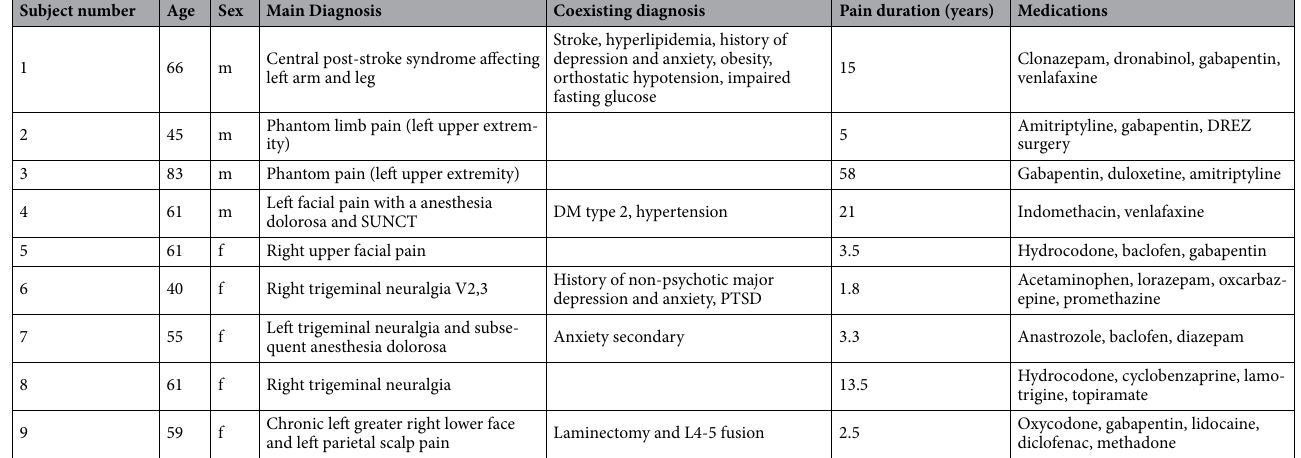
Table 1. Summary of initial clinical findings for patients in this study. DM diabetes mellitus, PTSD posttraumatic stress disorder, DREZ dorsal root entry